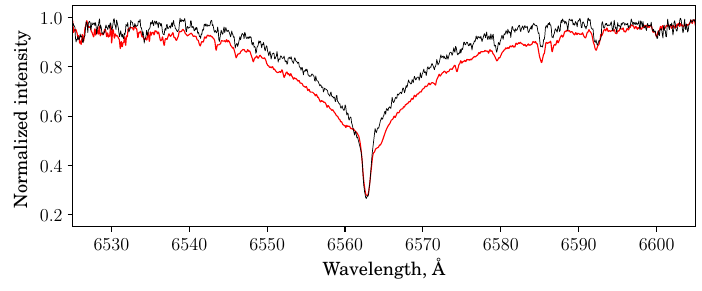
Figure 3. Hydrogen line H β in HD6757 spectra. The deformation of the transition between the core and wings of the line is clearly